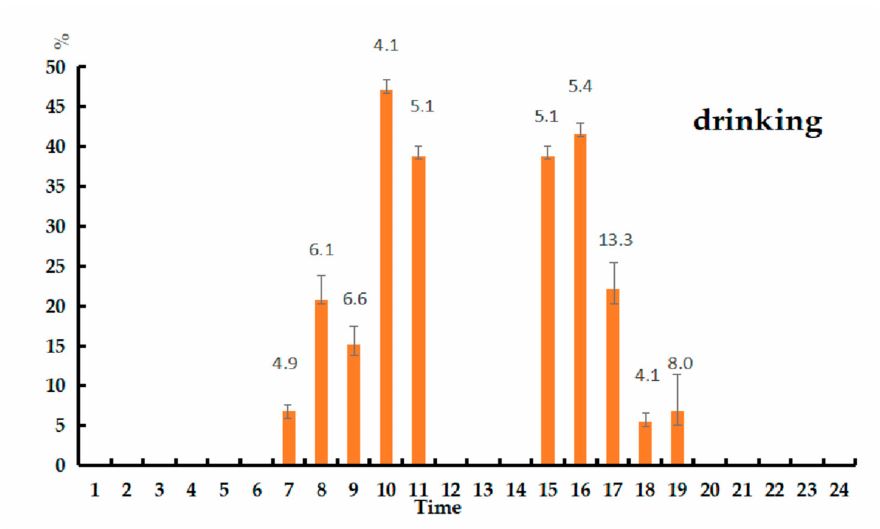
Figure 16. Percentage of lying time in 24 h.